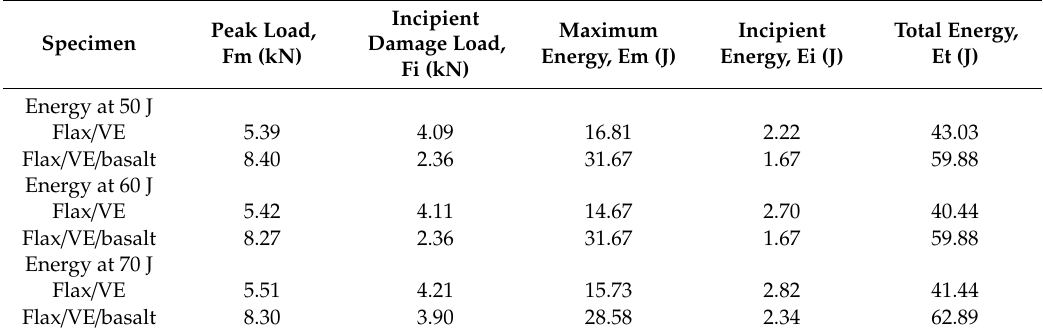
Table 2. Important impact parameters and corresponding values obtained from impact testing.